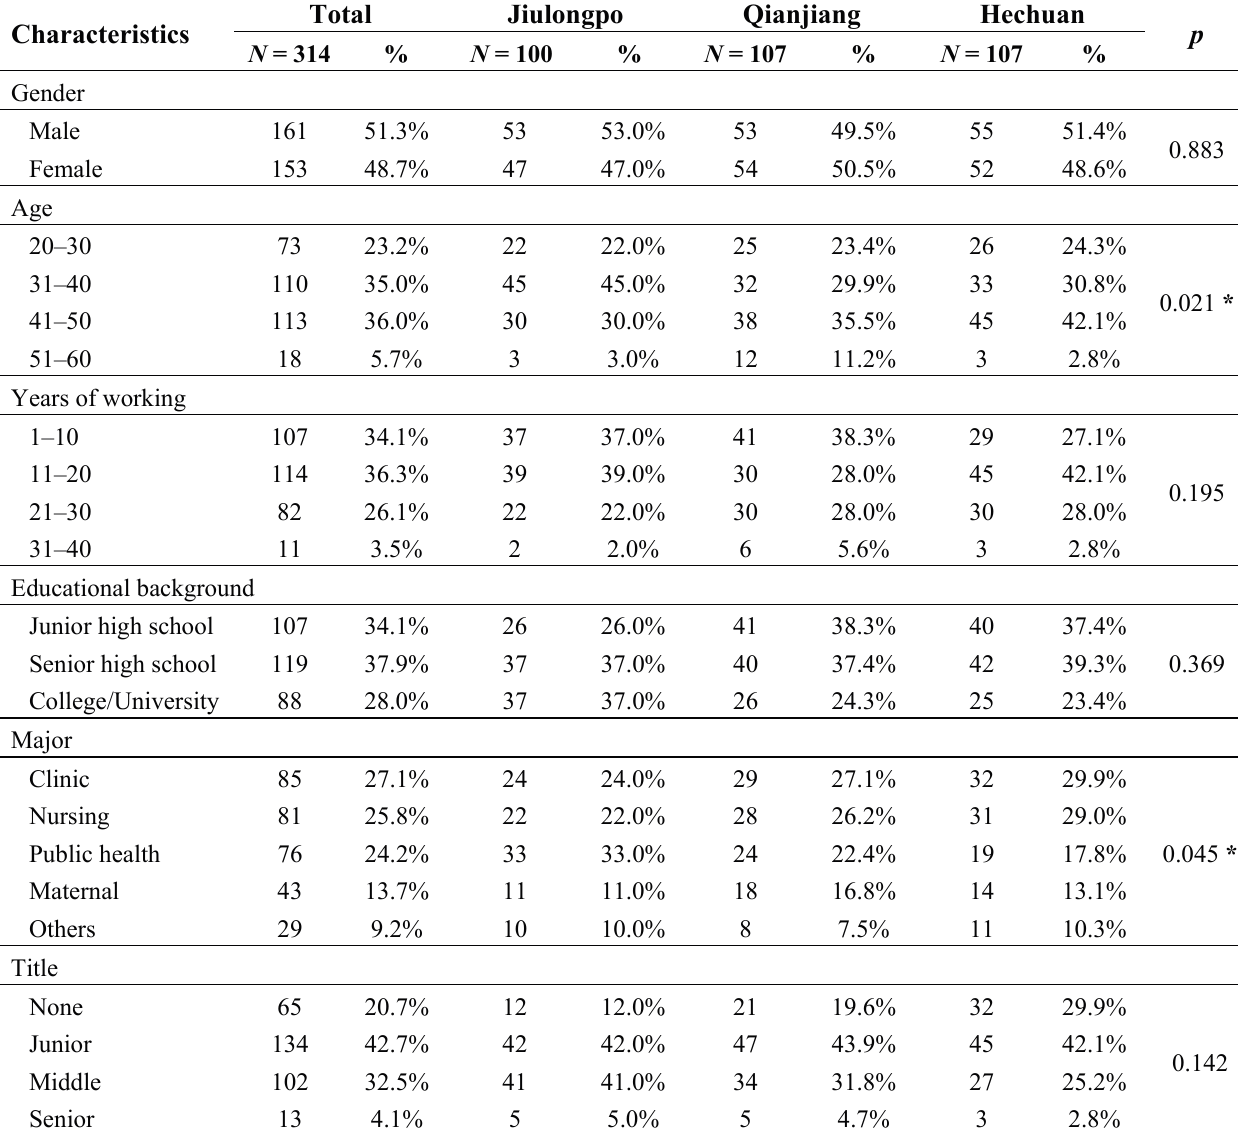
Table 2. Demographic characteristics of the PHWs in township